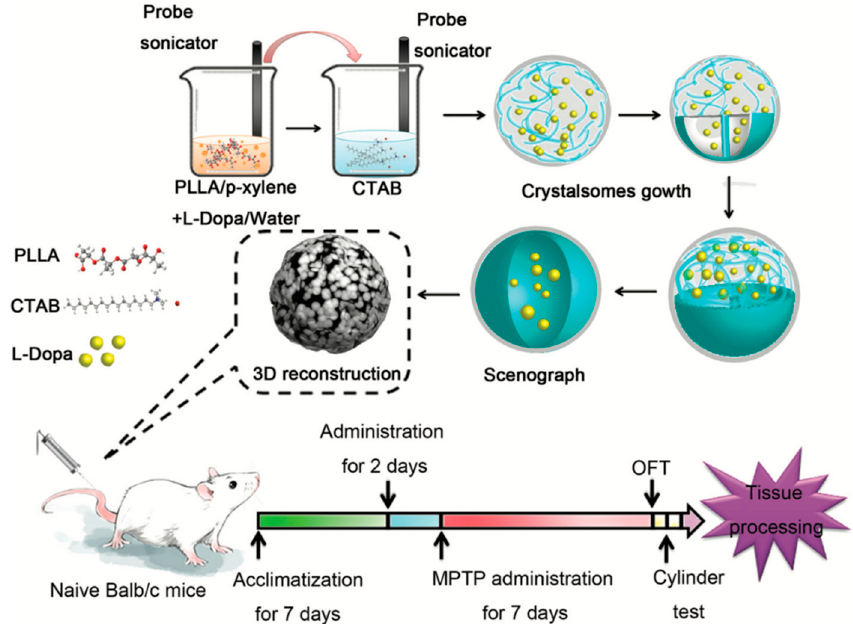
Figure 4. LD crystalsome preparation and experimental dosing The LD crystalsomes were obtained after quenching to a pre-set crystallization temperature for 48 h. The synthesized LD crystalsomes were given to the naive mice twice. Then all mice were administrated with MPTP for 7 days to the induced Parkinson-like mouse model. Mice were sacrificed after the behavioral test and examined for pathological changes. (Reproduced with permission from [65], Royal Society of Chemistry, 2013). 1-methyl-4-phenyl-1,2,3,6-tetra- hydropyridine (MTPT); Poly (L-lactic acid) (PLLA);